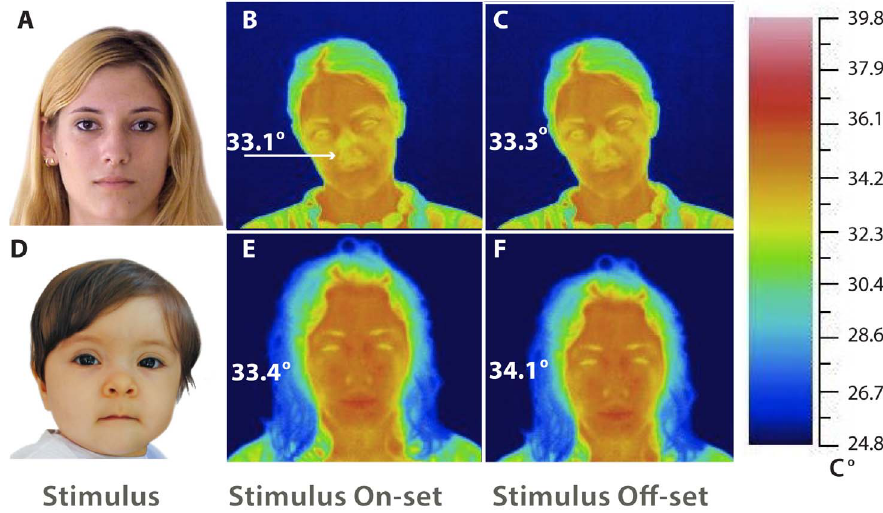
Figure 1. Examples of responses to the presentation of faces of Caucasian adults (A–C) and Caucasian infants (D–F). In the A–C sequence, A is the presented stimulus (Caucasian adult) and B and C show tip-of-the-nose facial temperatures, respectively, at the onset (33.1 u C) and at the offset (33.3 u C) of picture presentation. The white arrow in B points to the tip of the nose. In the D–F sequence, D is the presented stimulus (Caucasian infant), and E and F show the facial temperatures, respectively, at the onset (33.4 u C) and at the offset (34.1 u C) of picture presentation.